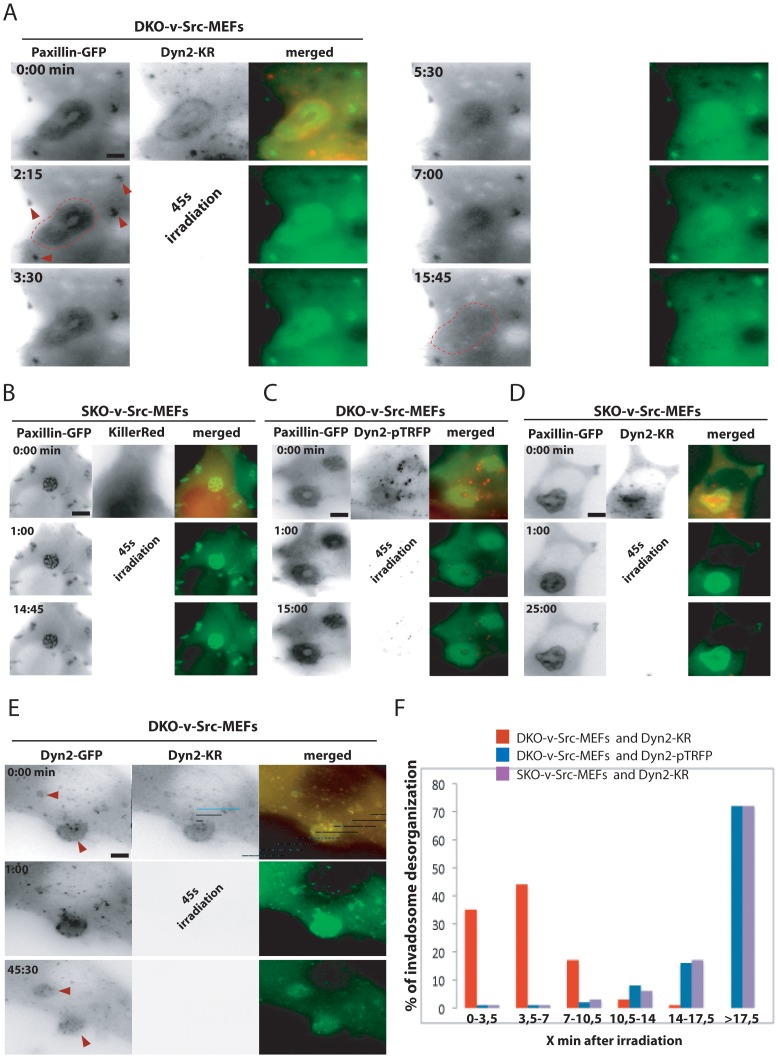
Specific dynamin photoinactivation led to the rapid invadosome disorganization.A) Extracted images from time serie (min∶s) from representative observations of DKO-v-Src-MEFs expressing dyn2-KR and GFP-paxillin. Dyn2-KR is functionnal while localized properly and rescued invadosome formation. KillerRed 45 s light irradiation is followed by the rapid dissociation of invadosome ring (dashed line) stained by GFP-paxillin also localized in focal adhesions (red arrows). B) Extracted images from time serie (min∶s) from representative observations of SKO-v-Src-MEFs expressing KillerRed (KR) alone and GFP-paxillin. Non-localized ROS production after light irradiation of KillerRed alone does not destabilize adhesions structures. C) Extracted images from time serie (min∶s) from representative observations of DKO-v-Src-MEFs expressing dyn2-pTRFP (same excitation/emission spectrum but much more photostable than KillerRed) and GFP-paxillin. Light irradiation without ROS production is not sufficient to dissociate invadosome structures. D) Extracted images from time serie (min∶s) from representative observations of SKO-v-Src-MEFs expressing GFP-paxillin and dyn2-KR. In presence of endogenous dynamin, photoinactivation of dyn2-KR has no effect on invadosome organization showing the localized and specificity of ROS produced by the photosensitizer on the proteins fused to it. E) Extracted images from time serie (min∶s) from representative observations of DKO-v-Src-MEFs expressing dyn2-GFP and dyn2-KR. ROS production at the level of the GTPase has no effect on dyn2-GFP stability visualizing and confirming the previous experiment. F) Distribution of the percentage of cells where invadosome structures is disorganized×min after light irradiation. The >17,5 min category corresponds to experiments where invadosome presented a life-span superior to 17,5 min (distributed between 20 and 40 min, depending of the duration of each movies) and pulled altogether. 16 to 56 cells per conditions were monitored. Scale bar = 2 µm (A, E), 4 µm (B, C, D).